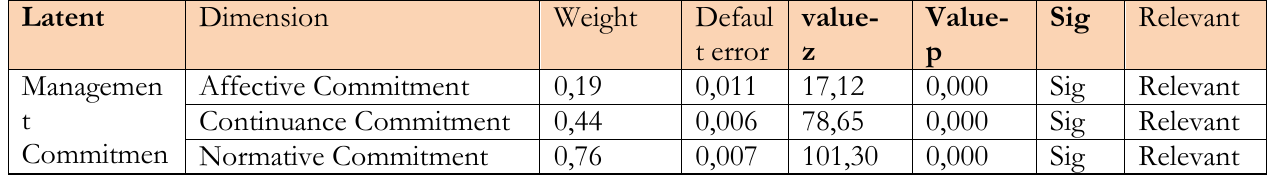
Table 1 Evaluation Results of Dimension Relevance